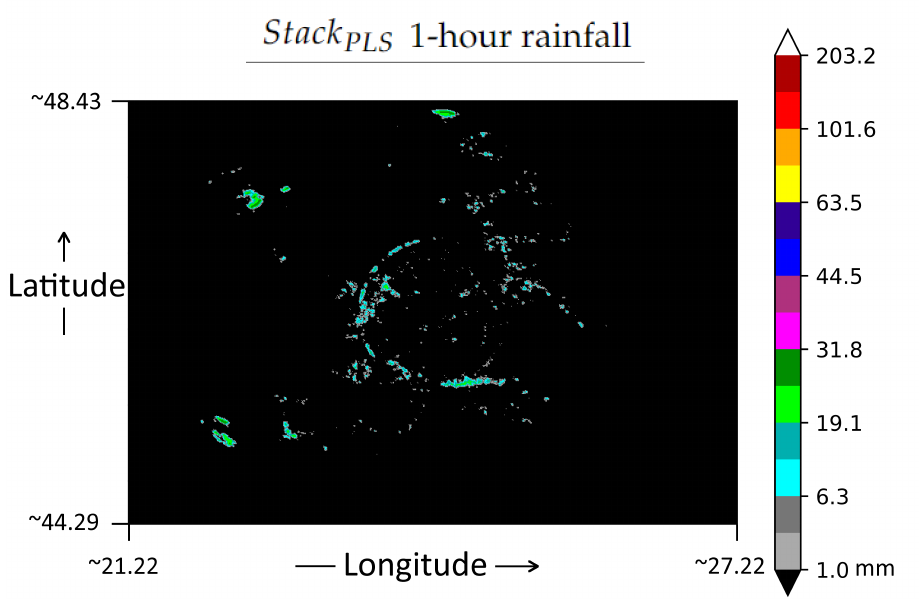
Figure 7. The 1-h rainfall estimation, in millimeters, provided by Stack PLS with d = 5 for 27 June 2016 at 18:59.